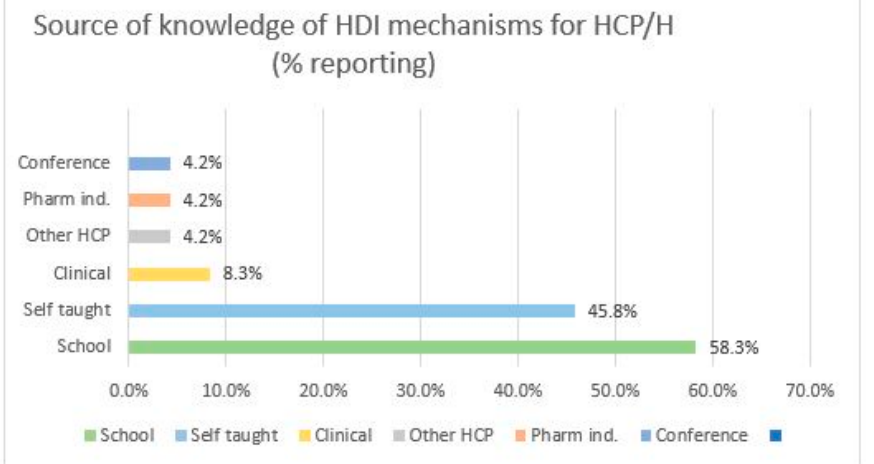
Figure 2. Source of knowledge among HCP/H. Pharm ind.: Pharmaceutical industry or groups; Other HCP: Other health-care provider; Clinical: Clinical experience.